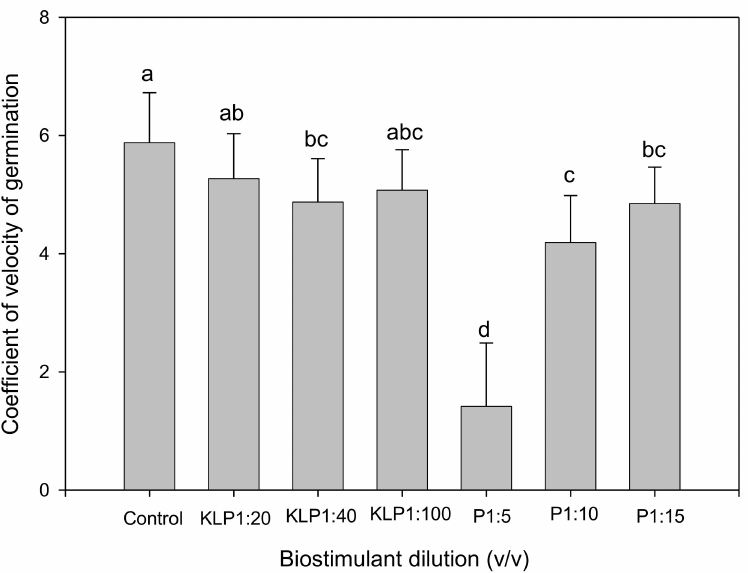
Figure 2. Effect of seed priming with biostimulants (KLP, Kelpak ® ; P, plant-growth-promoting rhizobacteria) on Abelmoschus esculentus seed coefficient of velocity of germination. Bars representing mean values and standard errors with different letters indicate statistically significant ( p ≤ 0.05)